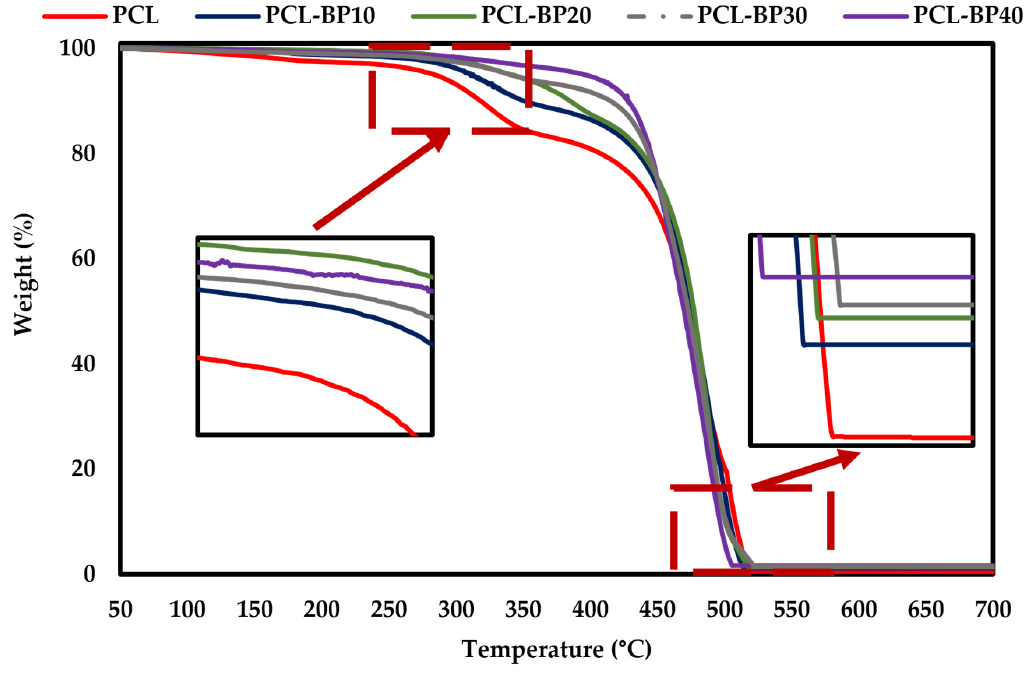
Figure 11. TGA thermograms of PCL and PCL-BP composites.